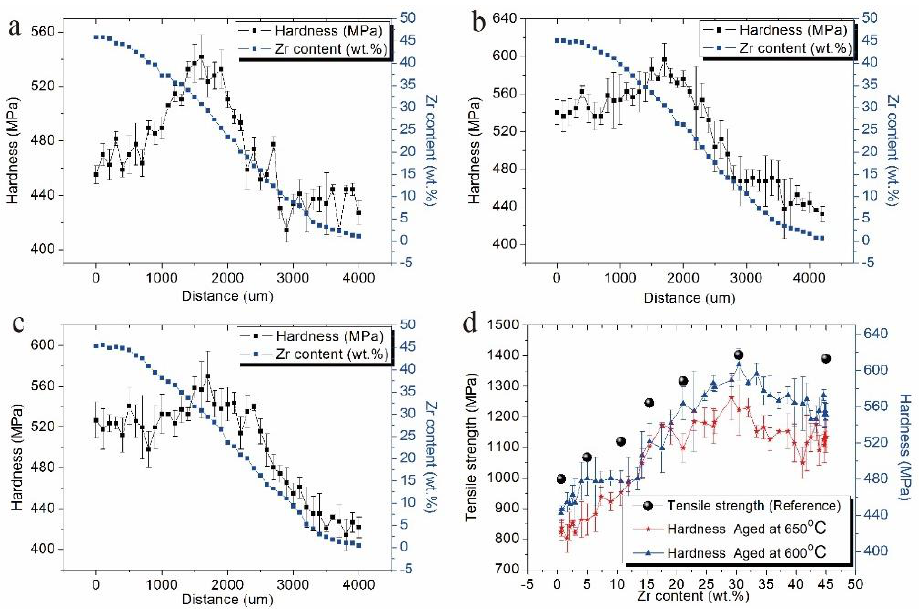
Figure 8. Composition-hardness relationship of the series Ti6Al4VxZr alloys: ( a ) after beta annealing; ( b , c ) after aging at 600/650 °C ; ( d ) hardness of aged alloys compared with reference. After aging at 600 °C, the hardness increased from 439 MPa to 605 MPa as Zr content increased from 0 wt.% to 30 wt.% and then decreased, as shown in Figure 8b. After aging at 650 °C, the hardness